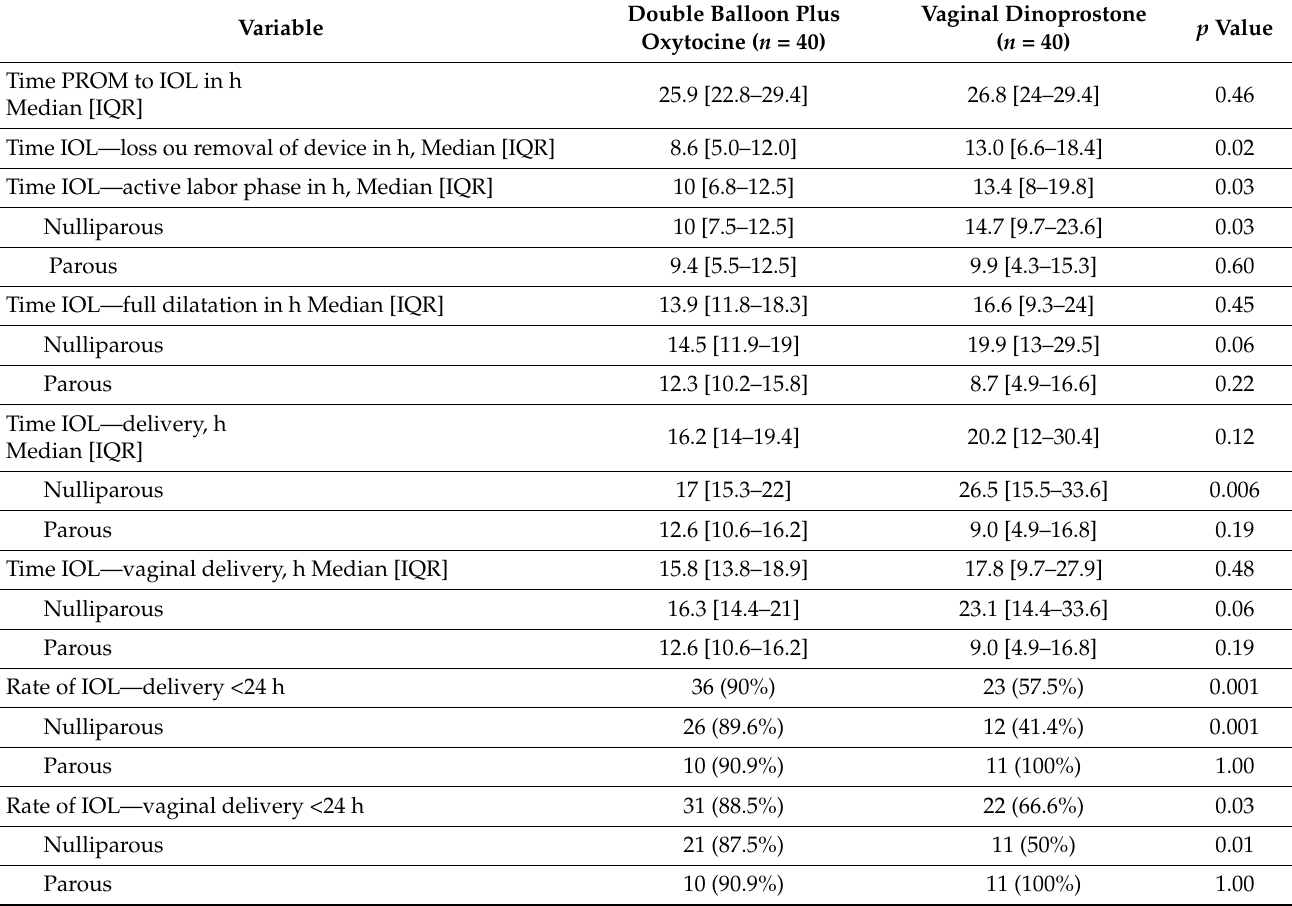
Table 2. Labor and delivery